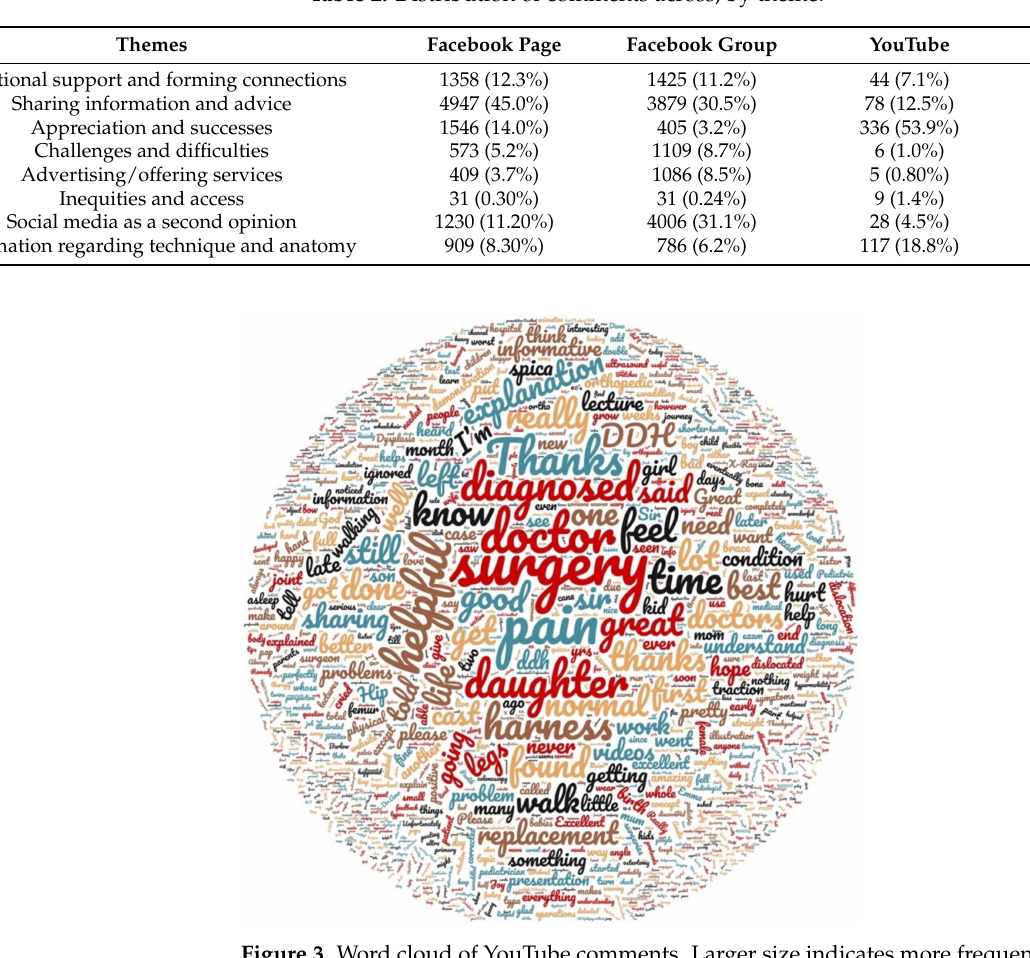
Figure 3. Word cloud of YouTube comments. Larger size indicates more frequently used words.